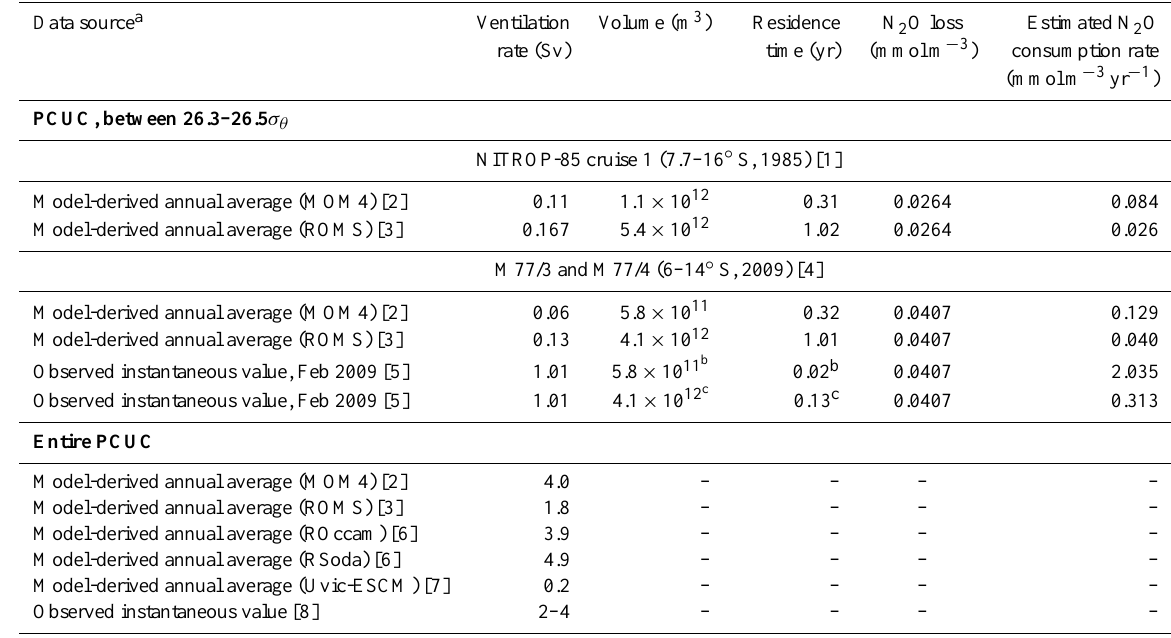
Table 1. Estimated N 2 O consumption rates within the Peru-Chile Under Current (PCUC) based on a range of estimated water mass residence times and on observed decreases N 2 O concentrations for two separate cruises. Further details on the models and calculations presented below can be found in Appendix